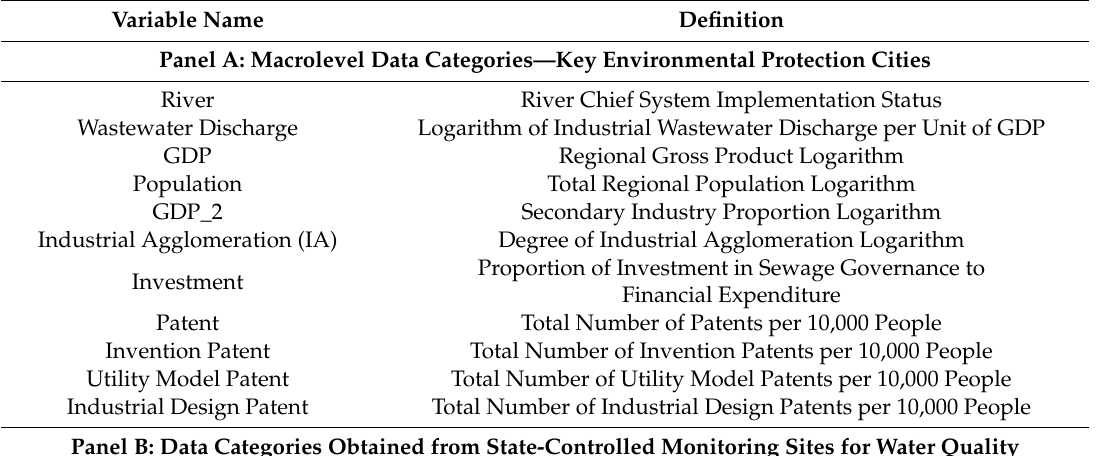
Table 1. Primary variables and